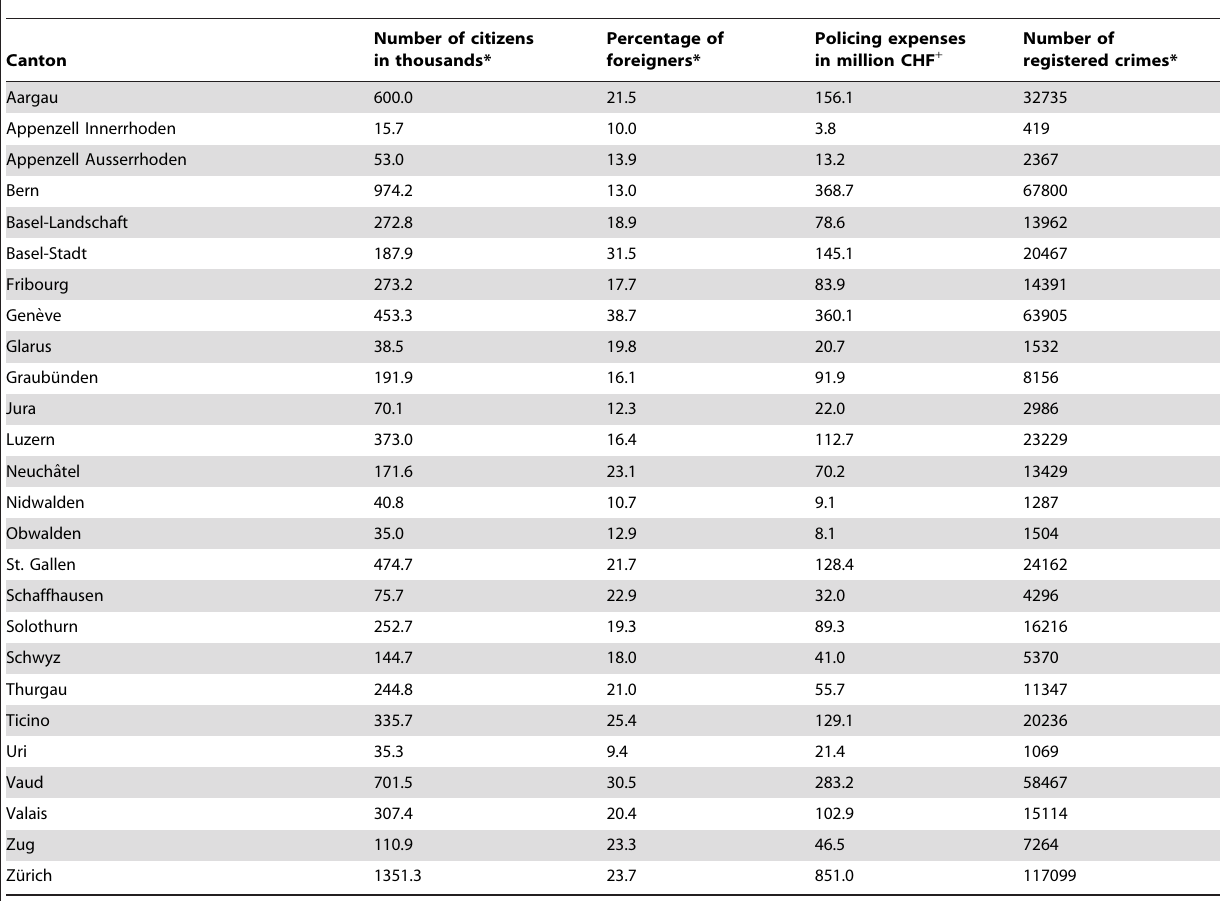
Table 1. Population demography, policing expenses and registered crimes of the 26 cantons of Switzerland.